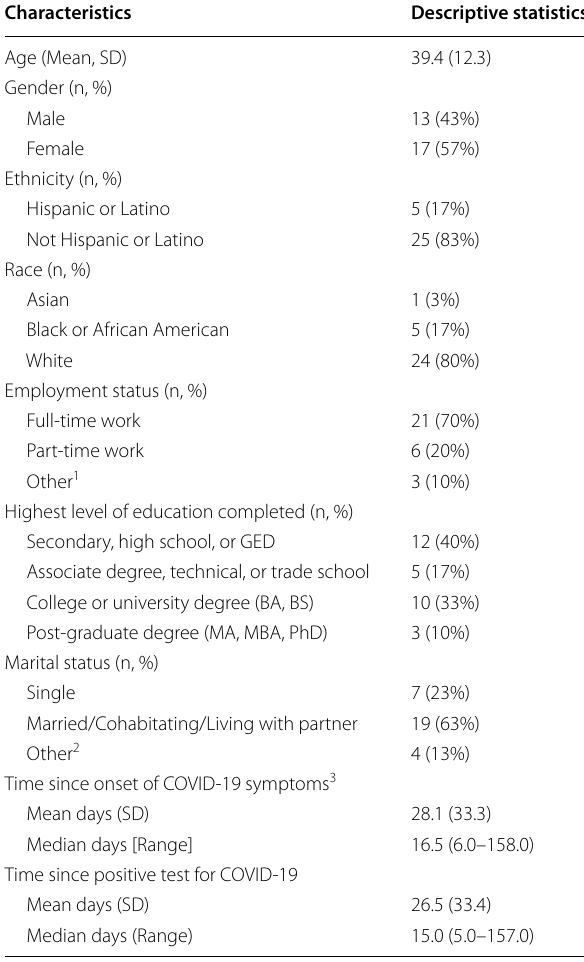
Table 1 Sample characteristics (N